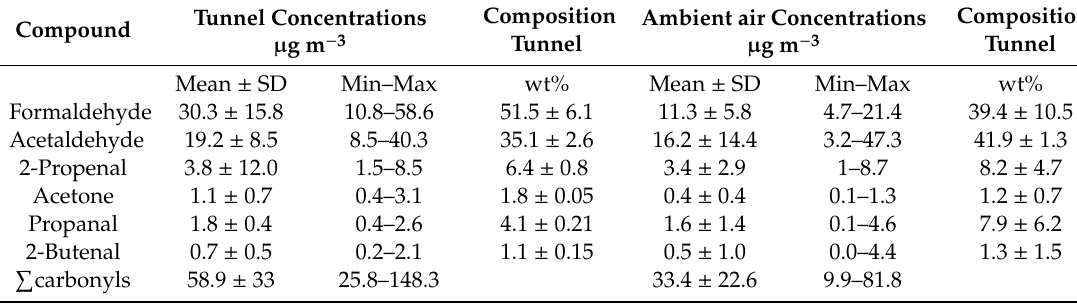
Table 4. Carbonyl compounds concentrations inside and outside the